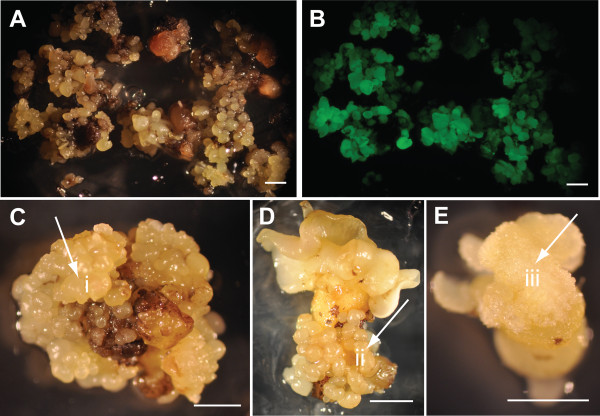
Effect of stable overexpression of TcLEC2 in cacao secondary somatic embryos. A &B. Secondary embryogenic explants transformed with Agrobacterium, regenerating stable transgenic E12Ω::TcLEC2 embryos were photographed under white and with GFP imaging optics, respectively. C, D &E. Transgenic somatic embryos expressing E12Ω::TcLEC2. (i) embryo-like structure formed on top of cotyledon (ii) embryo-like structure formed along embryo axis (iii) callus-like structure formed on top of cotyledon.